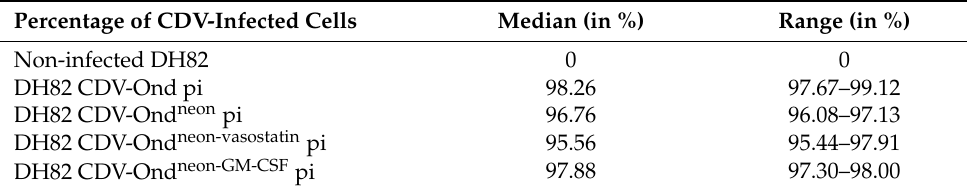
Table 1. Median and range of the number of CDV-Ond-infected cells assessed by CDV nucleopro- tein (D110) immunofluorescence.